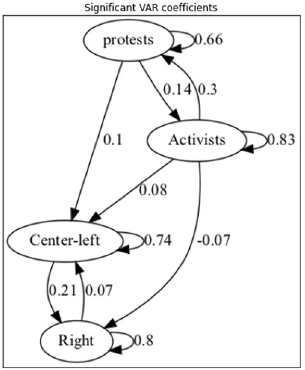
Fig. 4 Coef fi cients for full VAR model. Lag-1 coef fi cients for full VAR model signi fi cant at alpha = 0.01